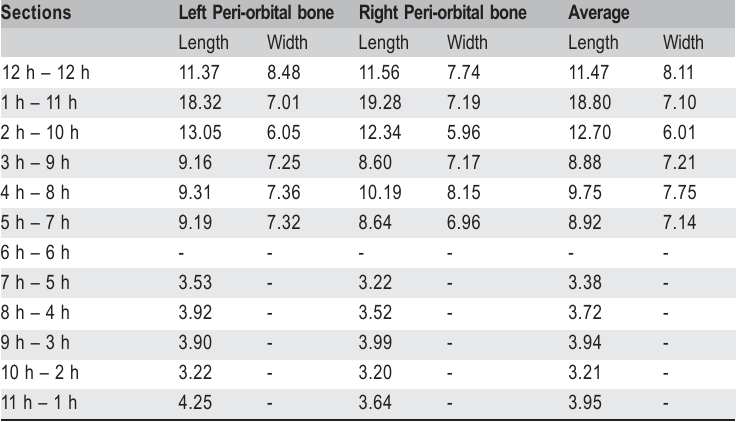
Table 5. Measurements of length and width of the right and left